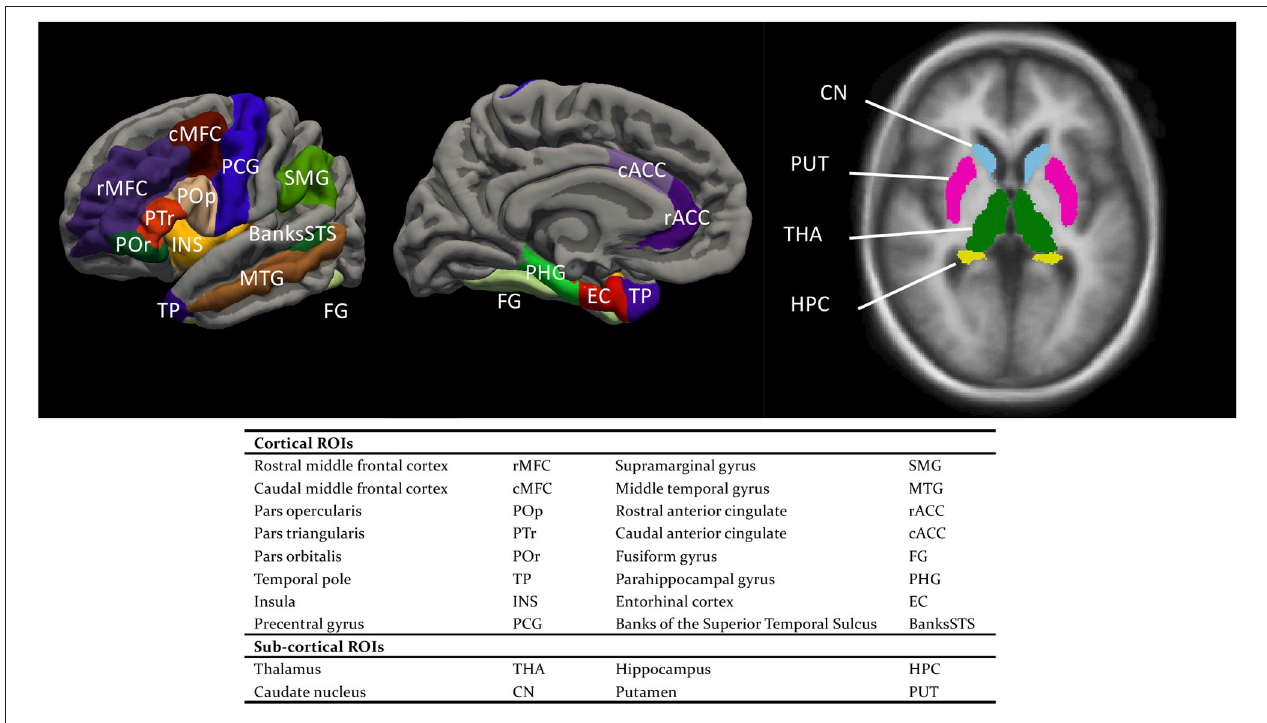
FIGURE 2 | Cortical and sub-cortical regions of interest (ROIs).